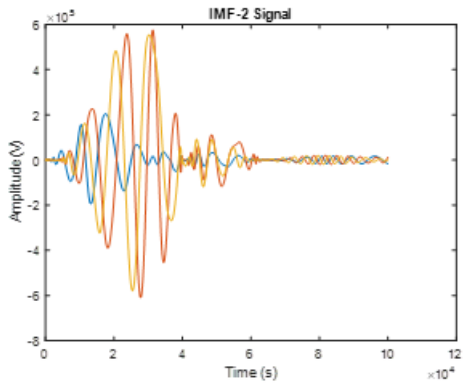
Figure 12. Simulation: wavelet Transform for phase- ground fault signal